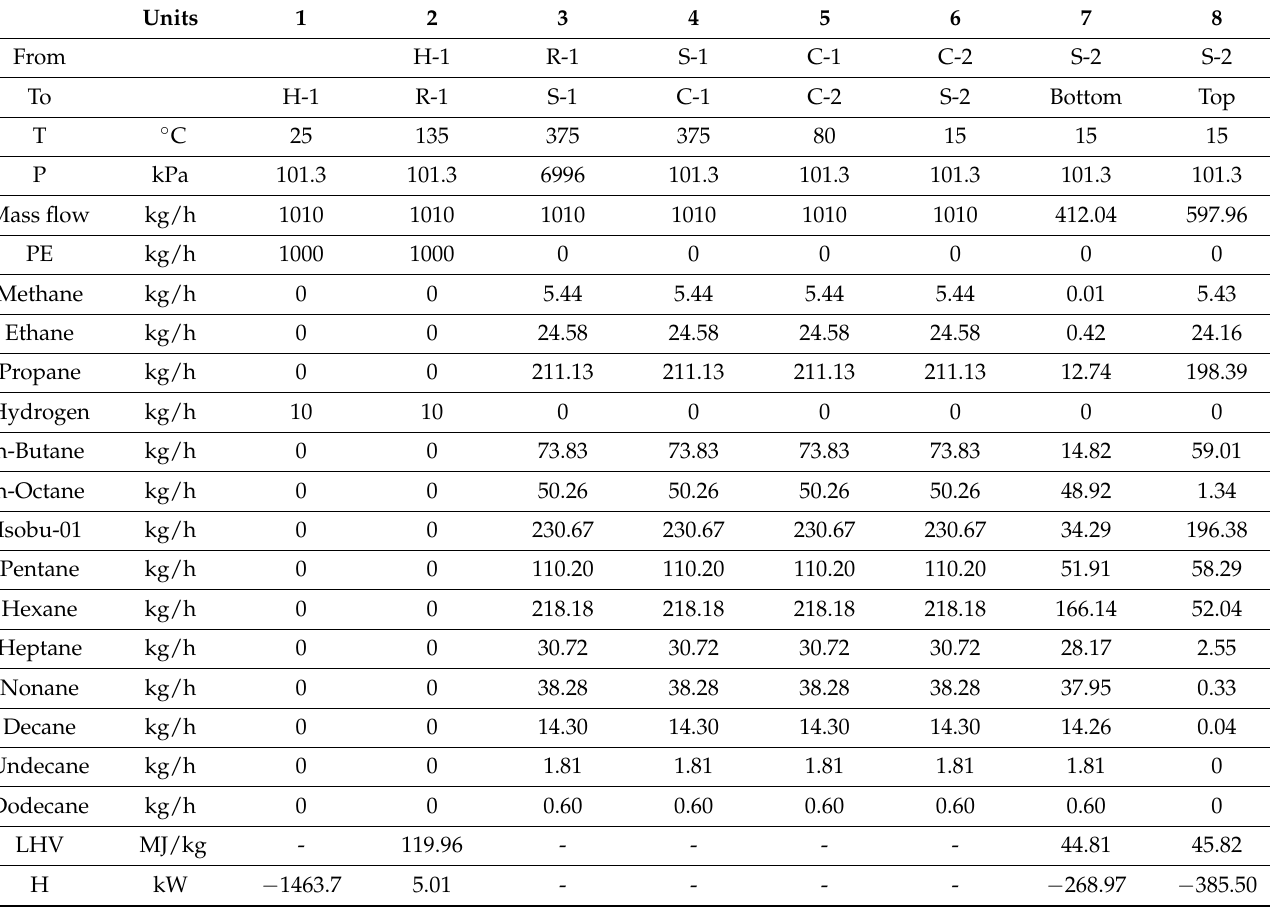
Table 3. Stream data for the hydrocracking process.